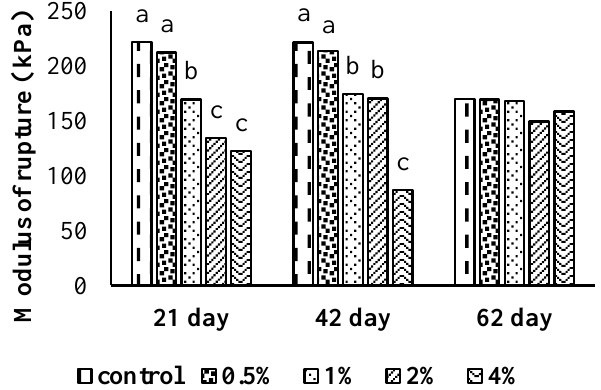
Table 2. Properties of the humic acid. Properties HA pH (H 2 O, 1:2.5)